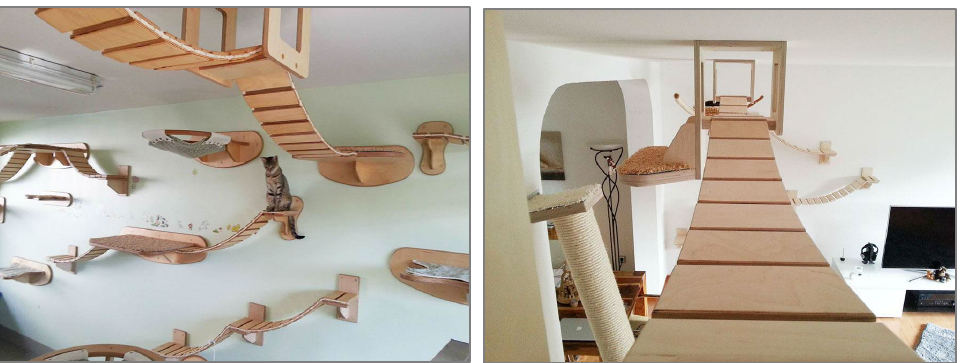
Figure 12 "Gold Paw" designed by Stefan Hofmann (URL-7)